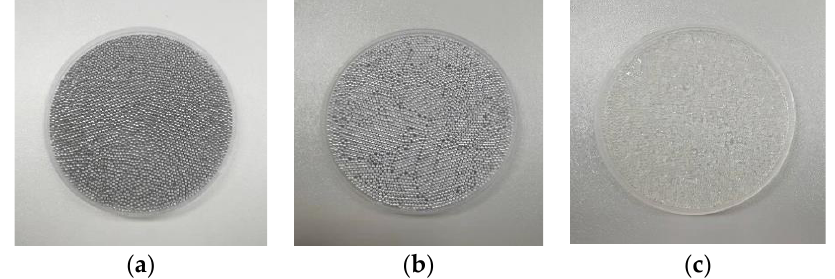
Figure 7. Three kinds of particle materials. ( a ) Steel ball; ( b ) Aluminum ball; ( c ) Glass ball.